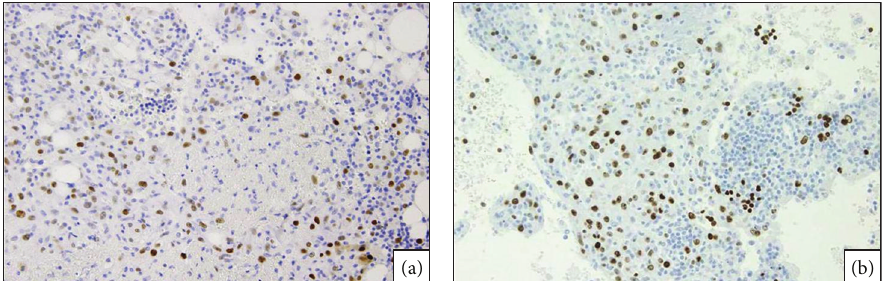
Figure 6: Immunopathological characteristics: approximately 5% of atypical epithelioid cells were positive for p53 ( × 1200) (a), and more than 30% of epithelioid cells were immunoreactive for Ki67 ( × 1200)